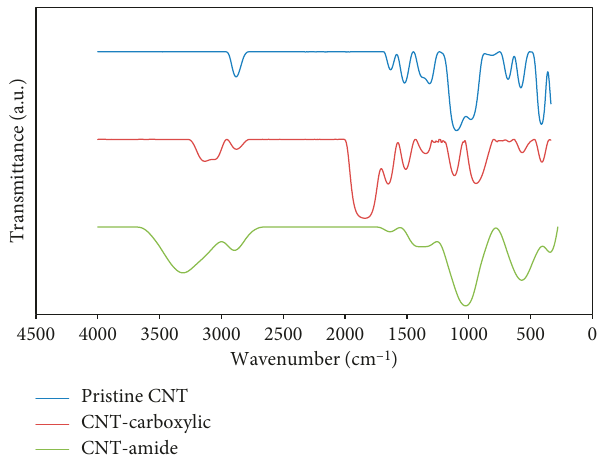
Figure 2: FT-IR spectra of (a) pristine CNT, (b) CNT-carboxylic, and (c) CNT-amide. Table 2: Intensity of peaks appeared in pristine CNT, CNT-carboxylic, and CNT-amide. Sample